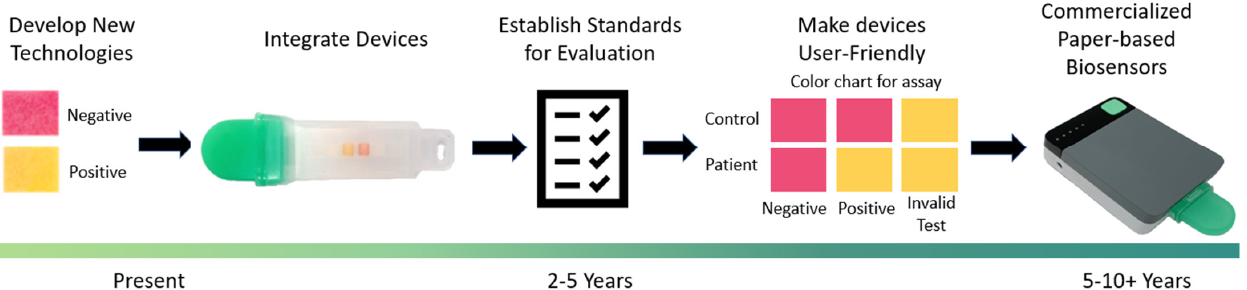
Figure 6. An overview of the process, challenges, and future prospects of developing commercial-